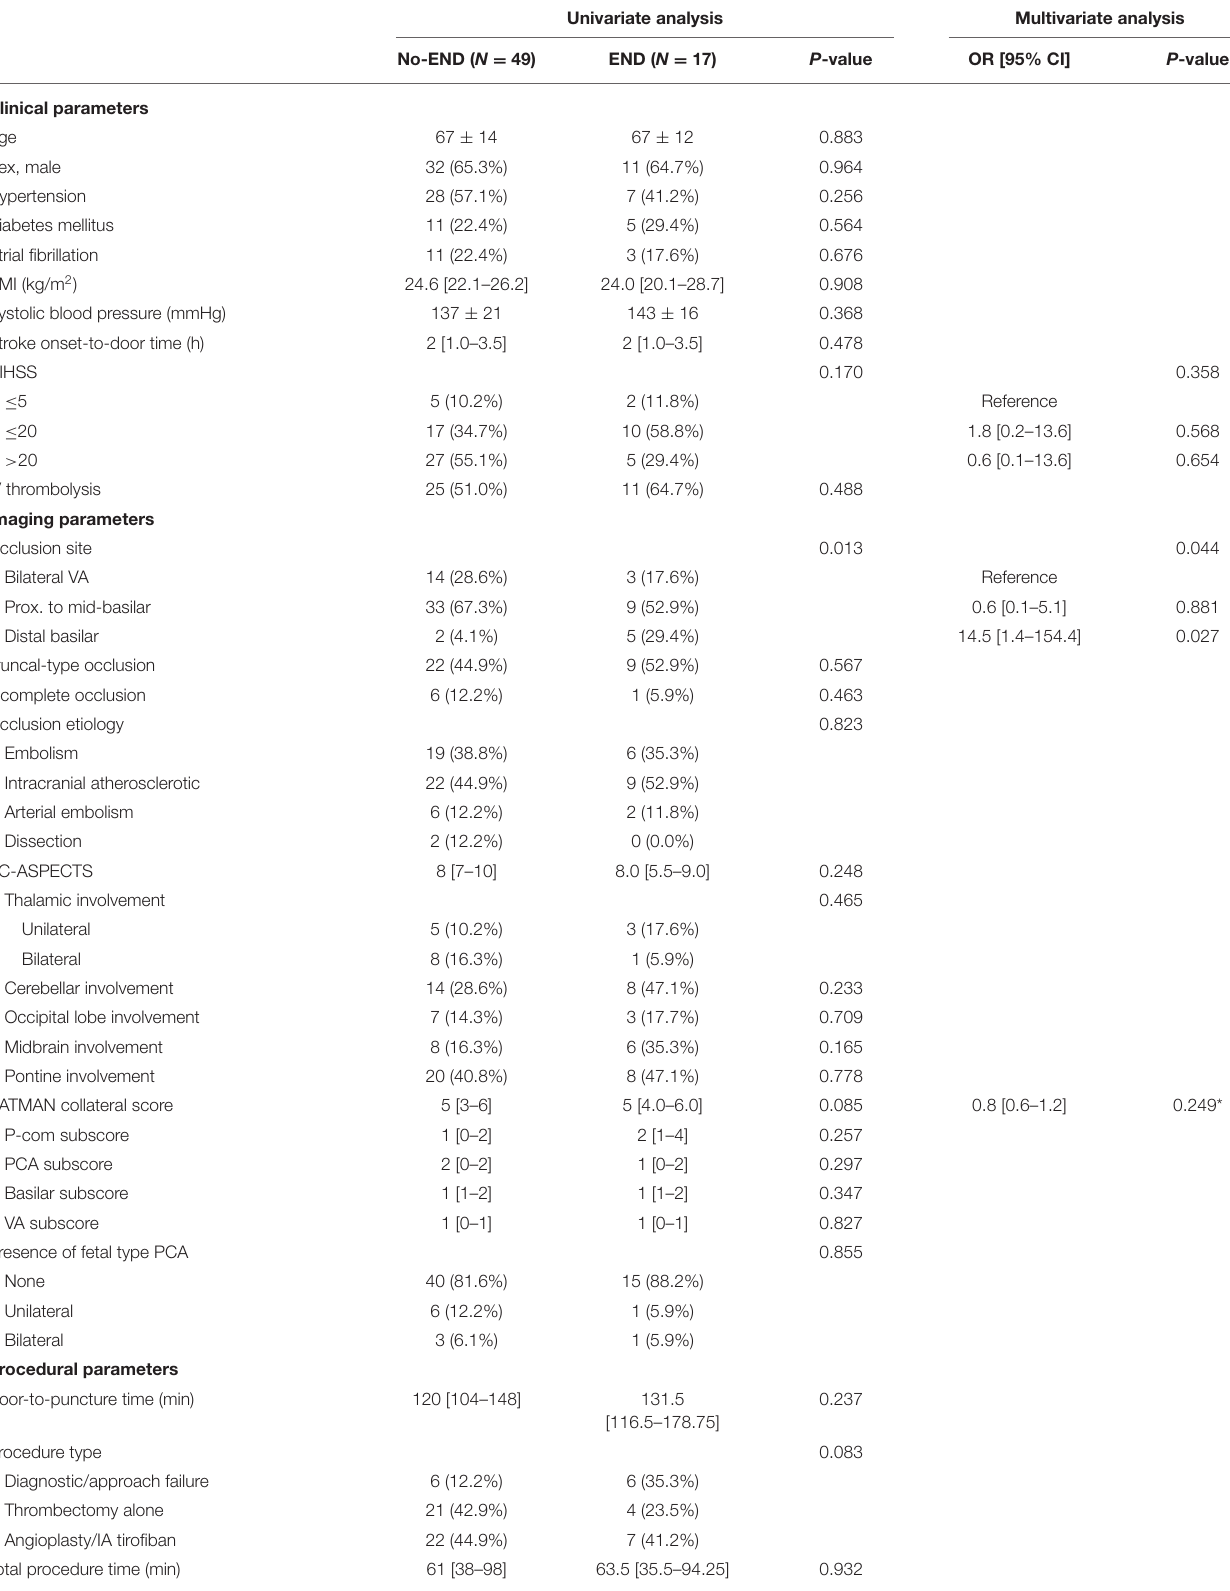
Univariate analysis Multivariate